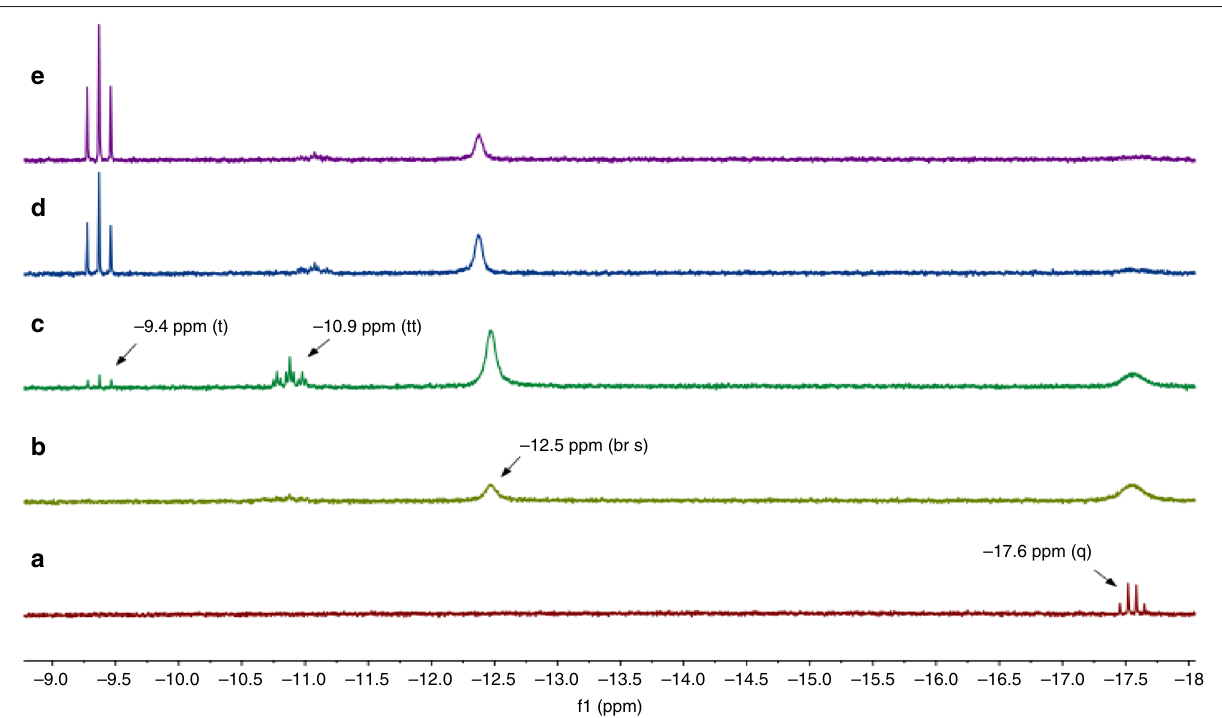
Fig. 6 Hydride region of 1 H NMR spectra of RuCl 2 (PPh 3 ) 3 in C 6 D 6 /methanol. a RT, argon atmosphere; b RT, H 2 atmosphere (1.5 bar), 10 min; c RT, H 2 atmosphere (1.5 bar), 2.5 h; d 60 °C, H 2 atmosphere (1.5 bar), 30 min; e 60 °C, H 2 atmosphere (1.5 bar), 1.5 h